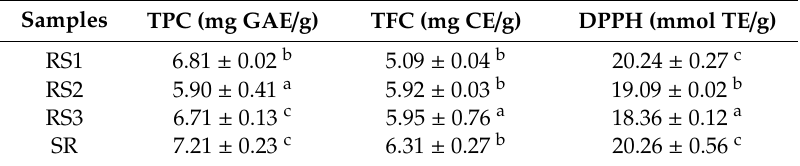
Table 2. Total phenolic and flavonoid content of Carissa edulis fruit samples.